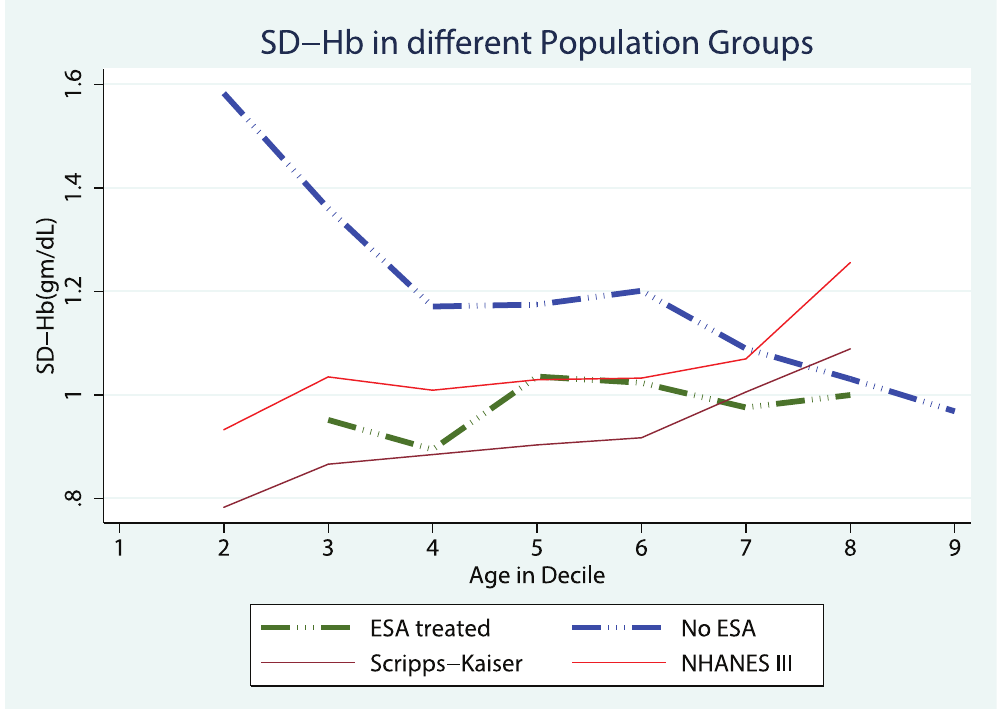
Figure 3. Hemoglobin Variability in different Population groups.